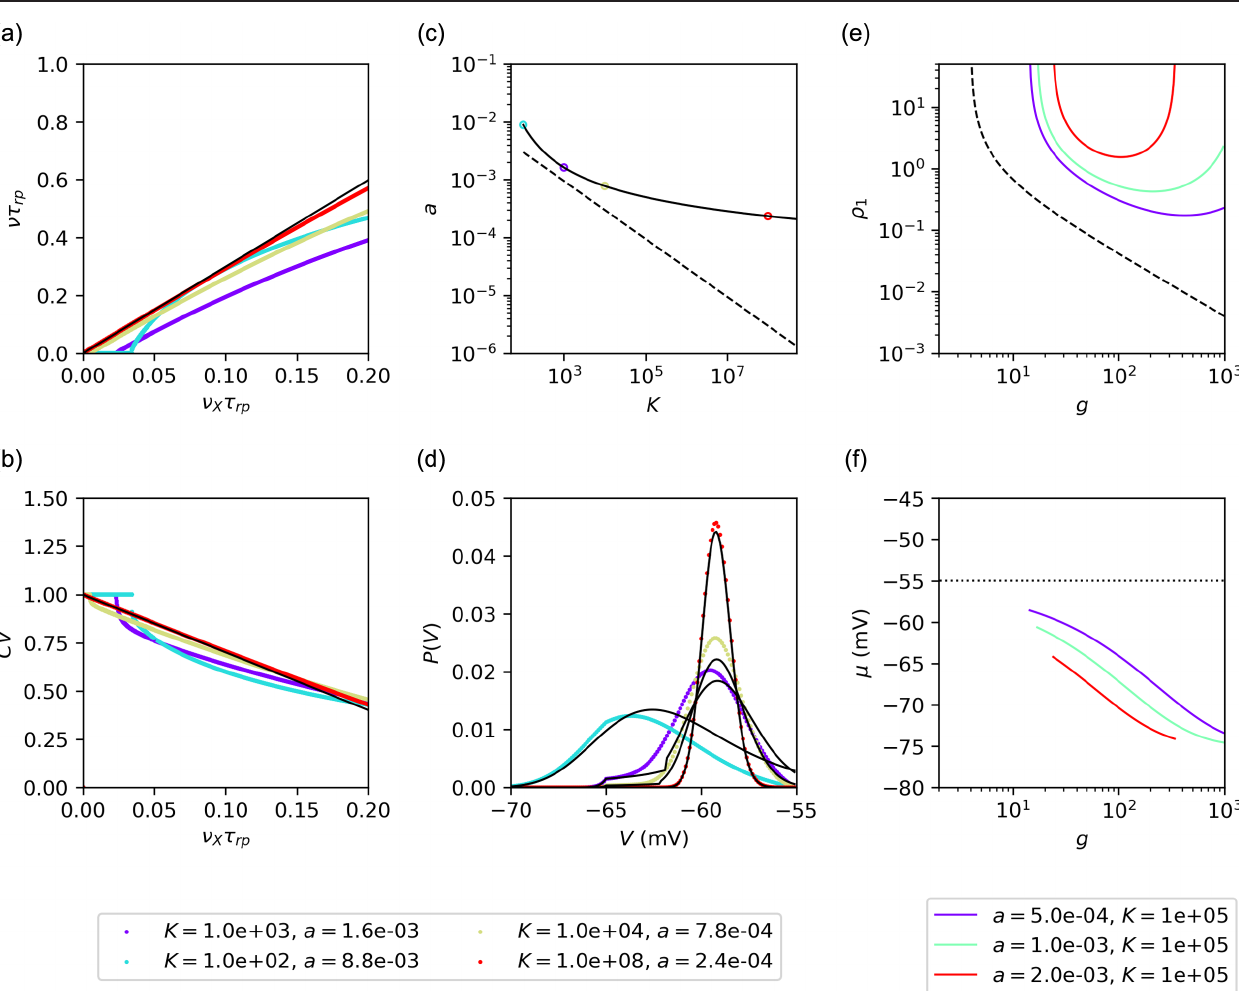
FIG. 12. Strong-coupling limit of networks of conductance-based neurons in model A . Numerically computed network transfer function (a), CV (b), and probability distribution of the membrane potential (d) obtained from Eqs. (D4), (A12), and (B17). Different colors correspond to different values of a and K which are changed according to the scaling relation (D10) (c). As K increases the network transfer function and CV converges to the expression derived in the main text (black lines). Note that, unlike the case of a single neuron, the network transfer functions become linear. The probability distribution of the membrane potential becomes Gaussian and slowly converges to a delta function. (e) and (f) show the network gain and membrane potential, respectively, for different values of a at fixed K . Note that, unlike what happens in current-based networks (black dashed lines), the gain is not monotonic with g . Simulation parameters are as in Fig. 9; in (a) – (d), g ¼ 20